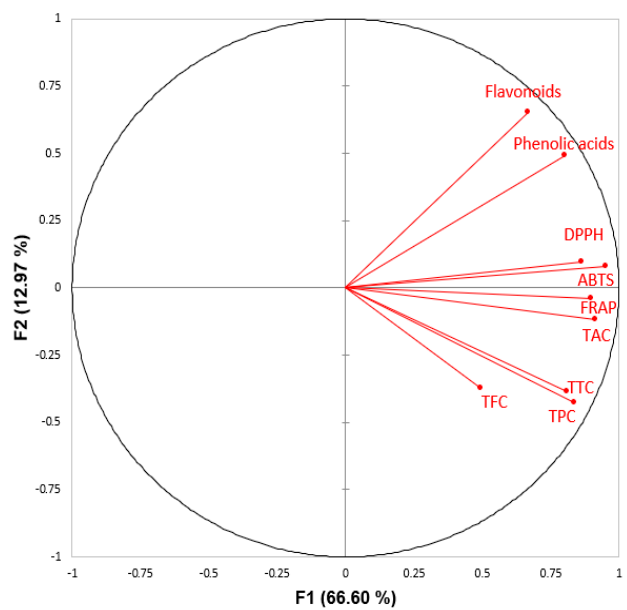
Figure 5. Principal component analysis (PCA) of the phenolic content (TPC, TFC, TTC, phenolic acids and flavonoids—quantified through HPLC-PDA) and antioxidant activities (DPPH, ABTS, FRAP, and TAC) of twenty different fruit peel samples.